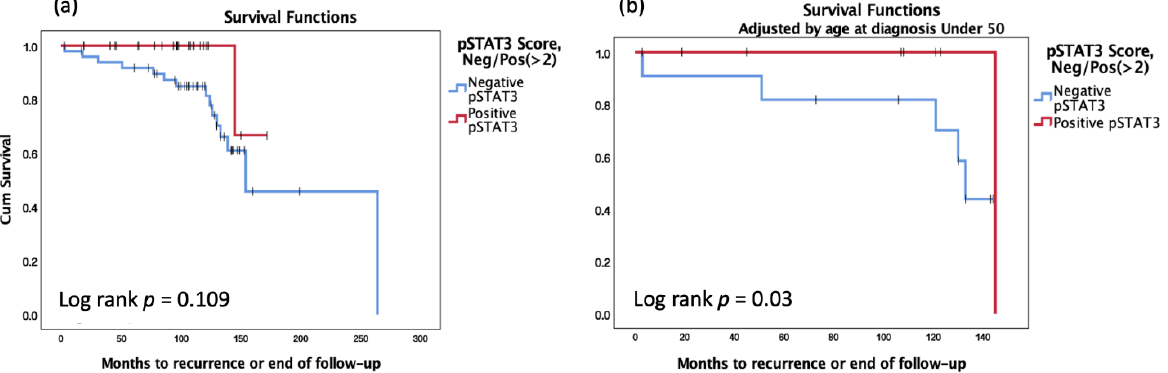
Figure 2. ( a ) Patients divided according to their pSTAT3 IHC scores; ( b ) patient allocation started according to RS scores.